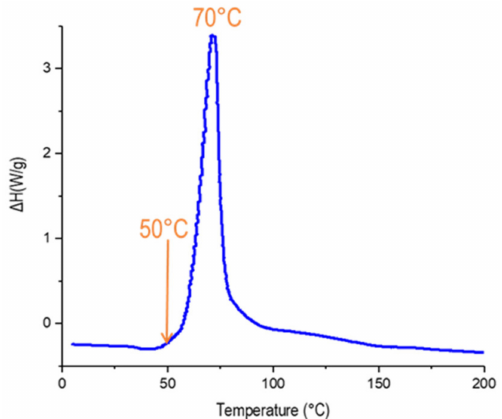
Figure 7. DCS evaluation of the thermal initiating ability of Blocbuilder ® MA (2 wt.%) in Mix-MA; under N 2 (100 mL / min); 10 ◦ C / min; 0–200 ◦ C.